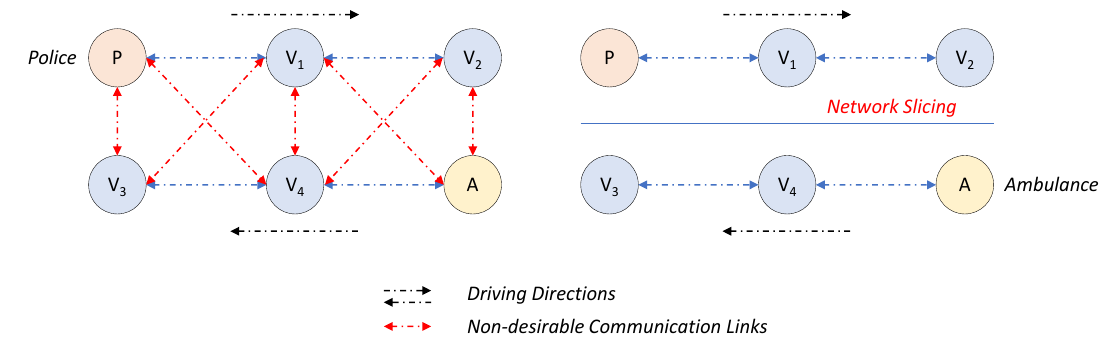
Figure 6. Depicting broadcast storm and network slicing in a vehicular networking